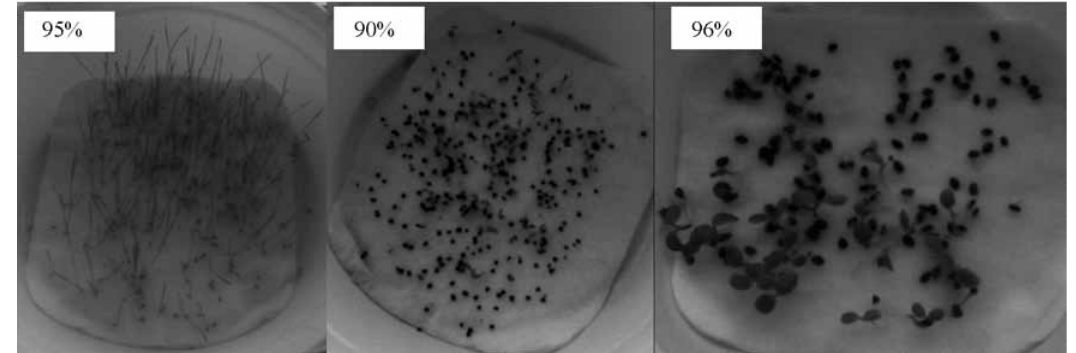
Fig. 1. Viability of seeds: timothy grass, white clover, crimson